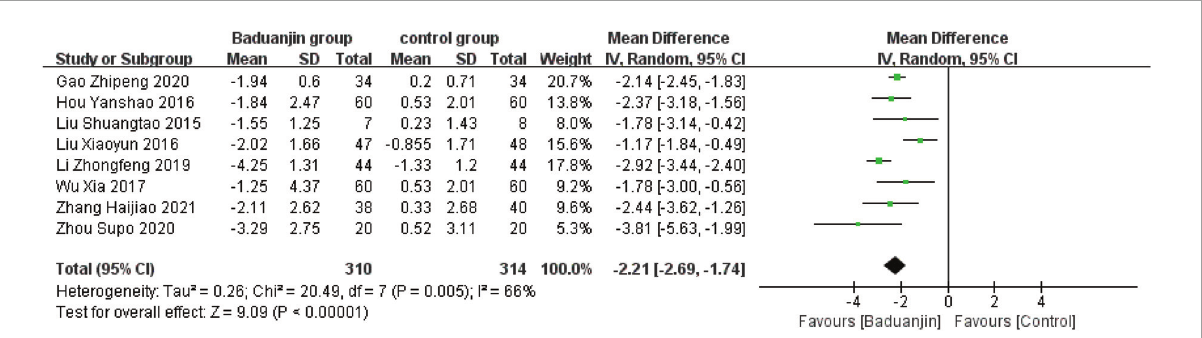
FIGURE4 Forest plot of the meta-analysis of TUG. The green squares and horizontal lines indicate the study-specific mean difference and 95% CIs. The size of the green area reflects the study-specific statistical weight. The black diamonds represent the mean difference and 95% CIs of each subgroup and the overall population.